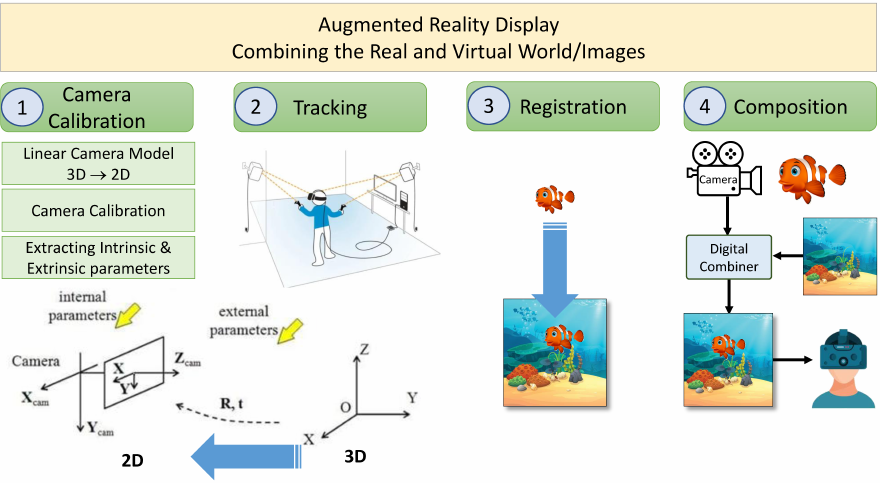
Figure 7. Steps for combining real and virtual